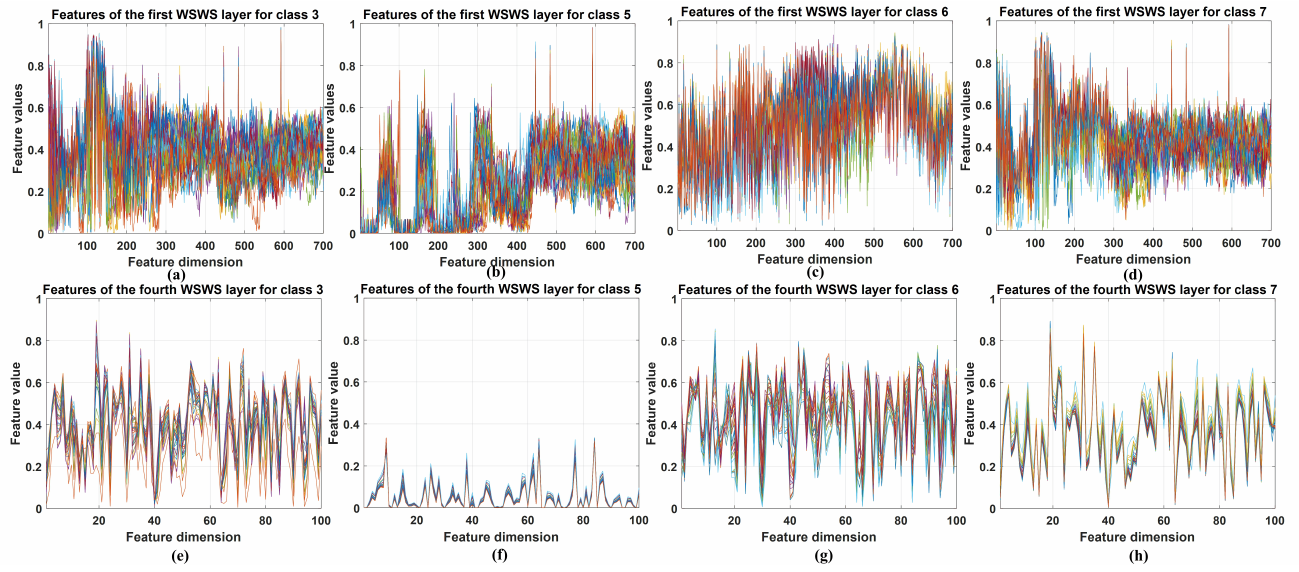
Figure 8. Visualization of the selected extracted features from the first and fourth WSWS layers of the Pavia University dataset. ( a – d ) The stacked results of extracted features of class 3, 5, 6, and 7 in the first WSWS layers from 30 training samples. ( e – h ) The stacked results of extracted features of class 3, 5, 6, and 7 in the fourth WSWS layers from 30 training